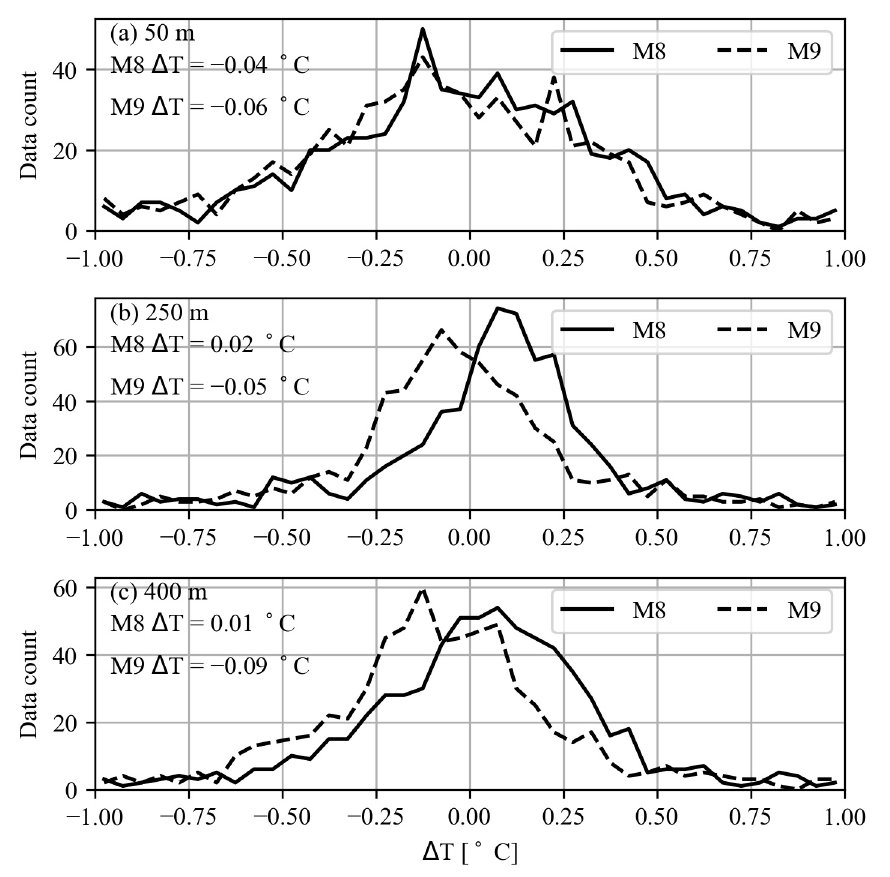
Figure 8. Distributions of ∆ T between the Argo-measured and model-predicted temperatures at three depths of ( a ) 50 m, ( b ) 250 m and ( c ) 400 m for model 8/9, respectively. The temperature bin is 0.05 ◦ C and the mean ∆ T is annotated in each